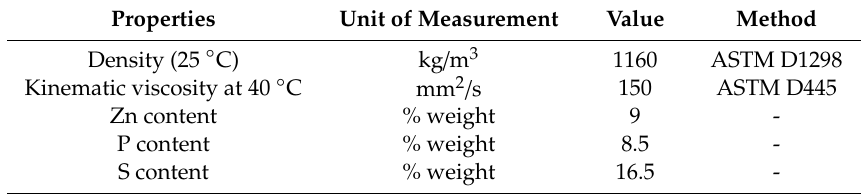
Table 2. Properties of the commercial zinc dithiophosphate (ZDDP) lubricant additive.